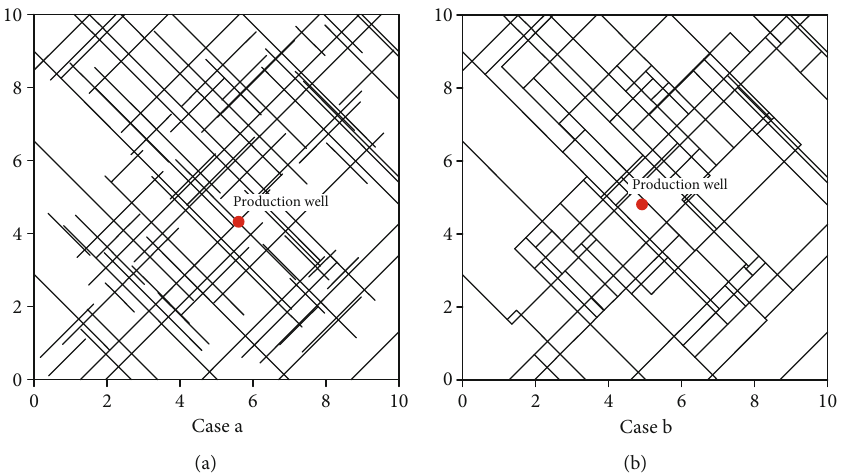
Figure 15: The original fracture network (Case a) and connected fracture skeleton (Case b).